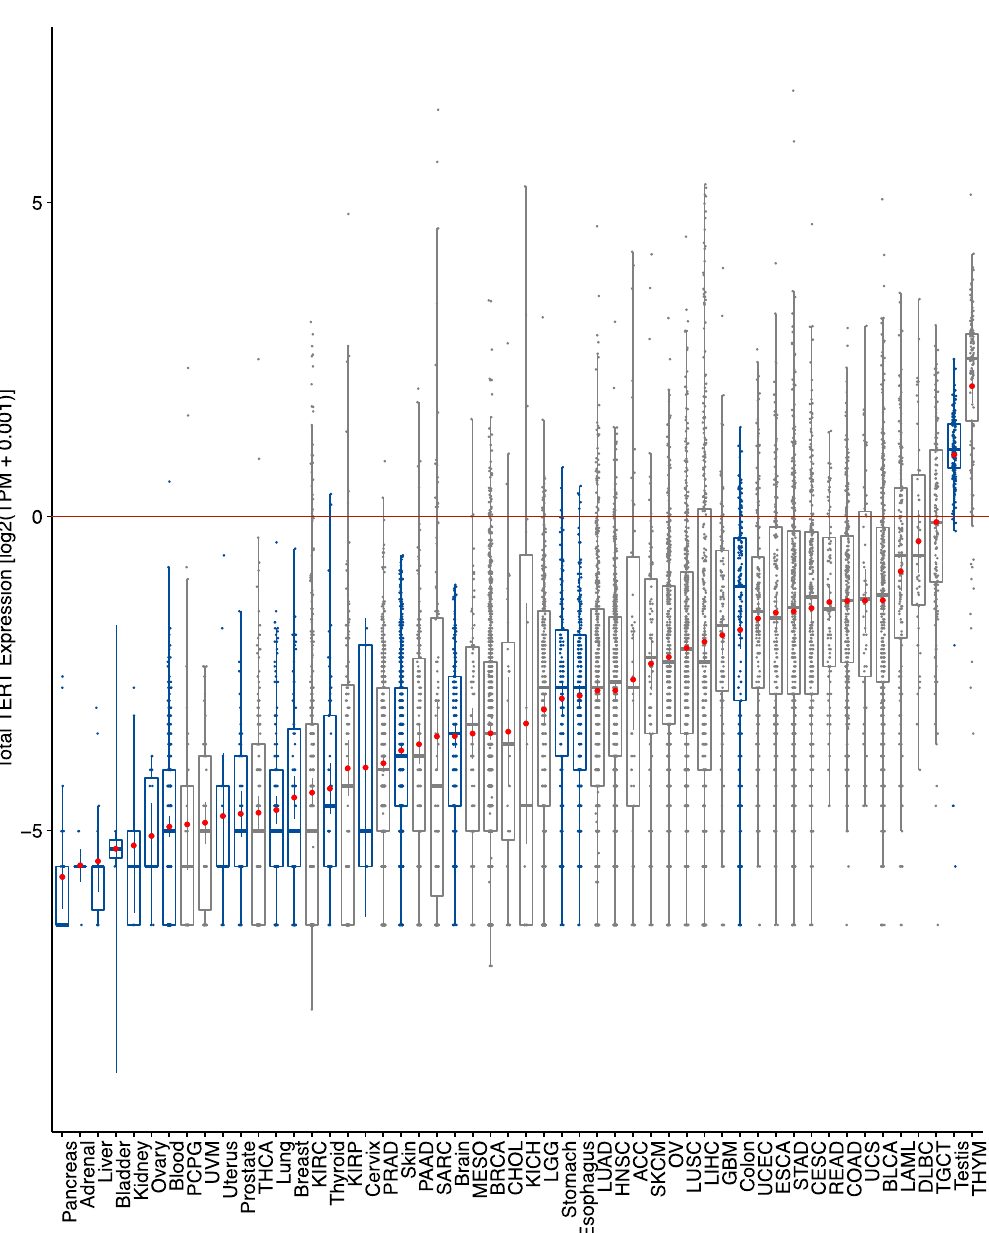
Figure 2. Variable total TERT expression observed across tumour and normal tissue types. Total TERT expression across TCGA tumours shows tumour-specific expression. Total TERT expression across GTEx normal tissue types shows the majority have low expression except for gastrointestinal and testicular tissue types. Box plots boxes denote the inter-quartile range as well as a bolded line representing the median. Extending from the boxes are minimum and maximum lines calculated from 1.5 times the interquartile range. Points outside this range are considered outliers. Within each box is a red point signifying the mean, as well as lines extending from this point representing a 95% confidence interval. Expression values in transcript per million (TPM) were transformed by a log 2 (TPM + 0.001) equation. Horizontal line at y = 0 indicates 1 TPM.